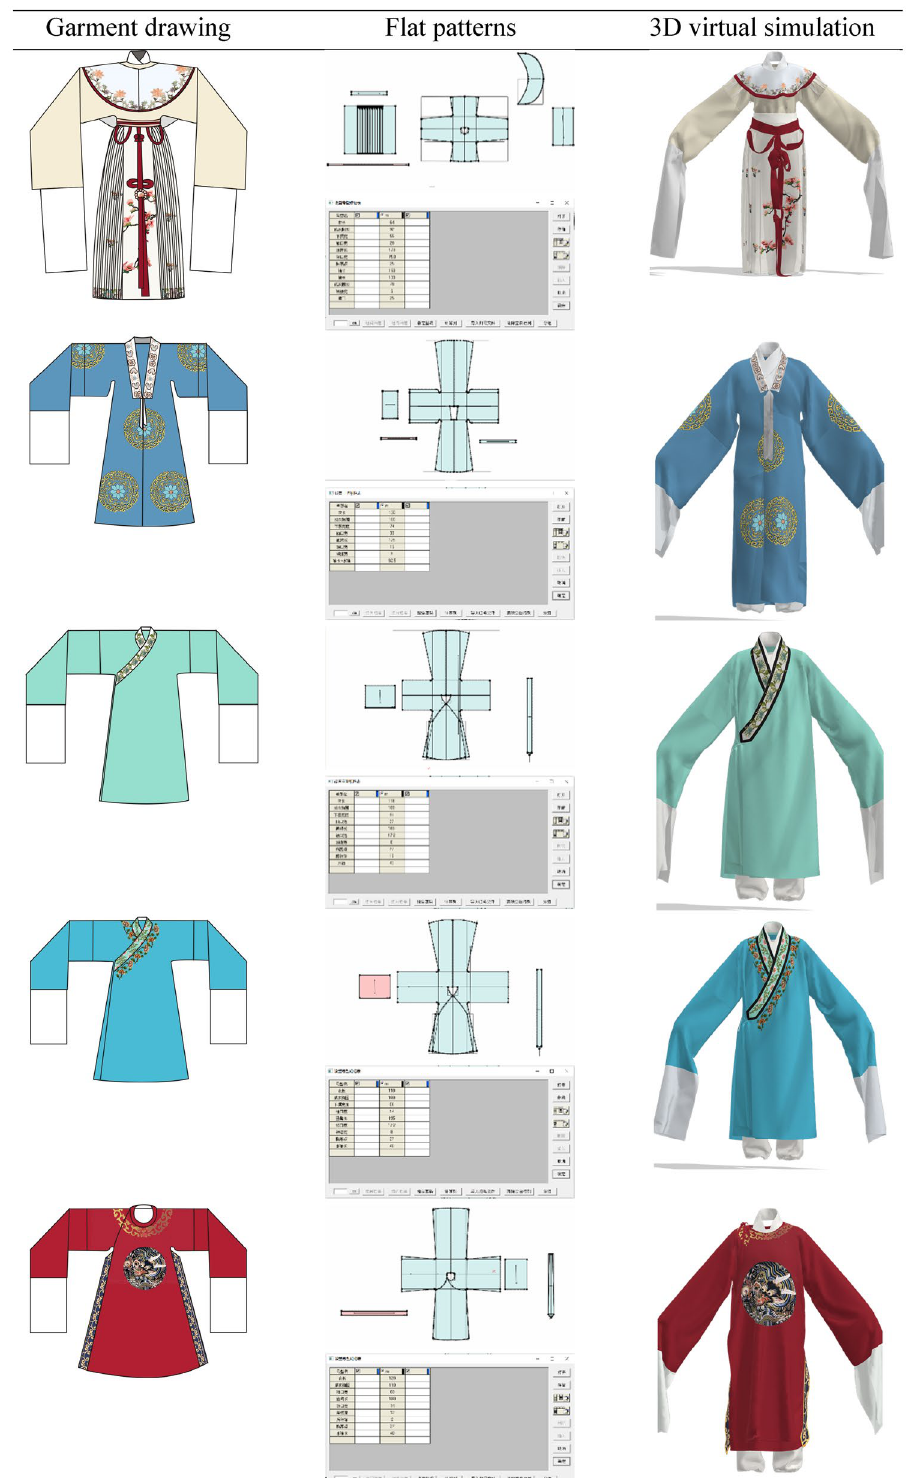
Fig. 7 Virtual simulation recovery